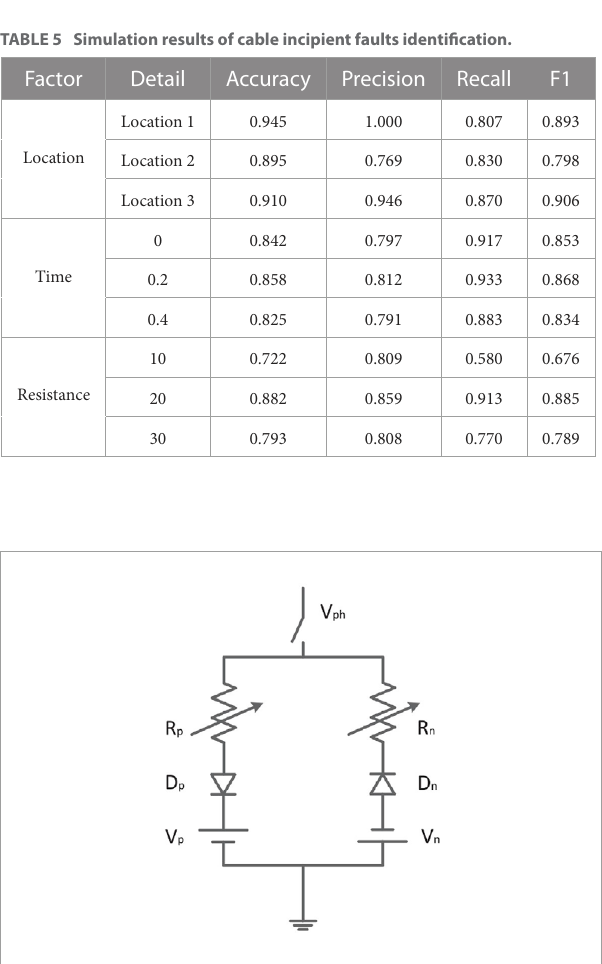
FIGURE 10 Arc faults model: two anti-parallel dc-source model. The positive half cycle of arc faults current is achieved when V ph > V p , while the negative half cycle is when V ph < V n . When V n < V ph < V p , the current equals zero, which represents the period of arc